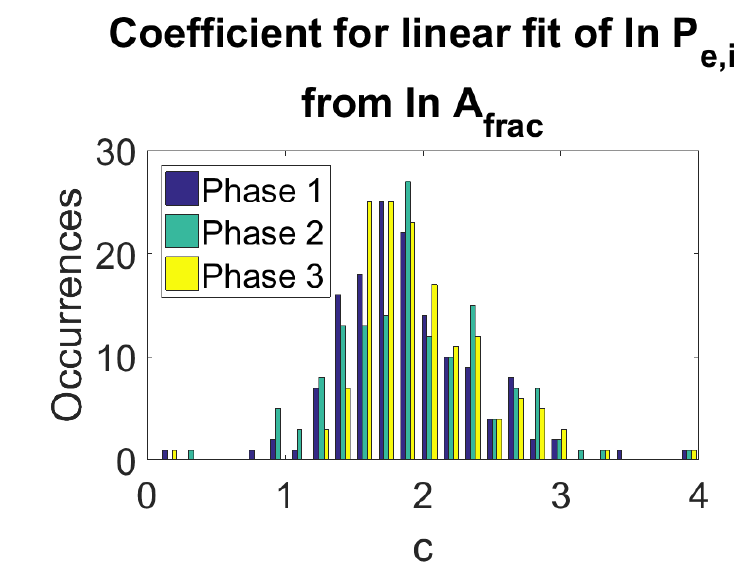
Figure 10. Histogram of the coefficients from the linear regression of lnP e , i ∼ lnA frac for phases 1, 2 and 3. The coefficients correspond to c .